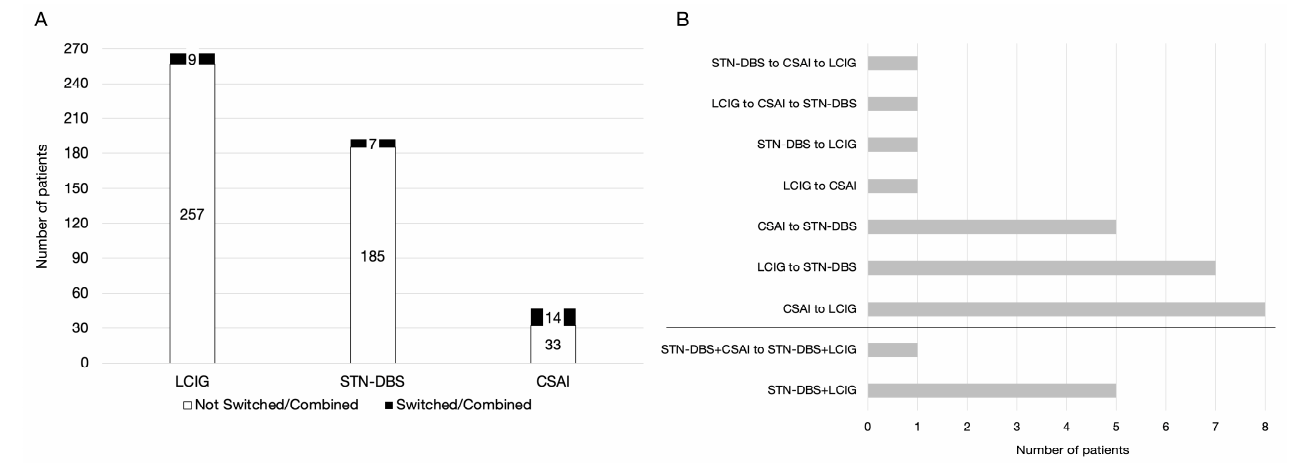
Figure 1. ( A ). Number of patients ( y -axis) who received continuous subcutaneous apomorphine infusion (CSAI), L-dopa-carbidopa intestinal gel infusion (LCIG), and deep brain stimulation of the subthalamic nucleus (STN-DBS) ( x -axis) from both centres. ( B ). Number of patients ( x -axis) on specific switches and combinations of DATs ( y